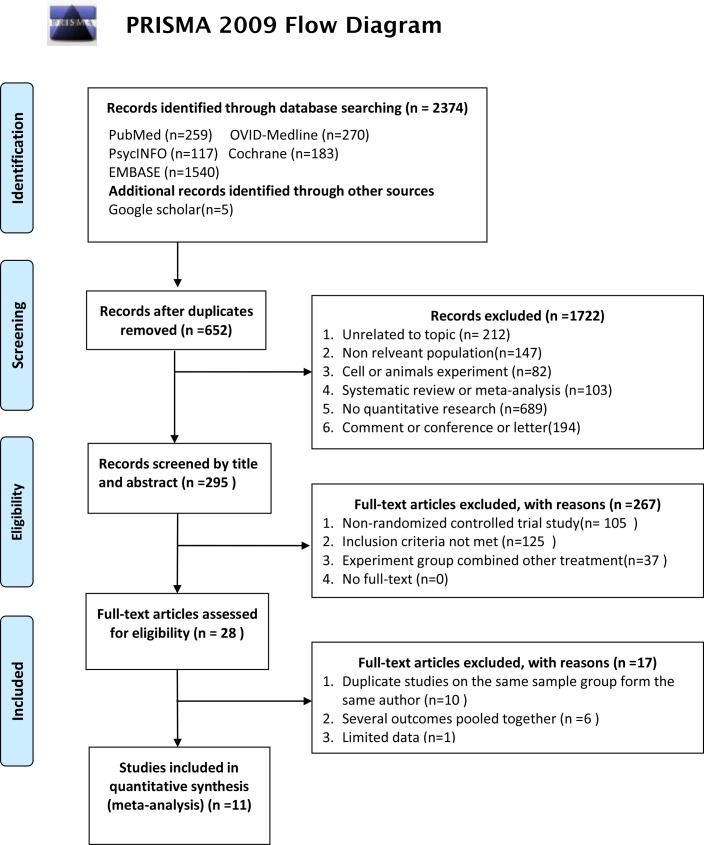
Study selection flow chart.